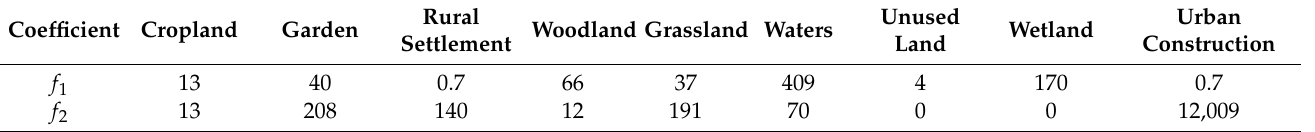
Table 2. Coefficient of the objective